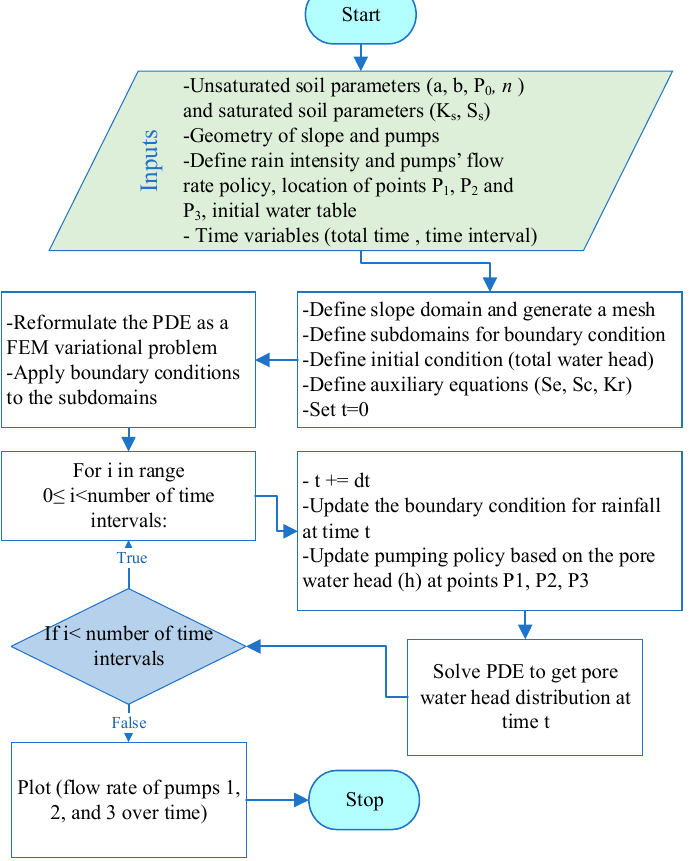
Figure 4. Flowchart of the written python code using DOLFIN package to solve the governing equation for transient seepage analysis.